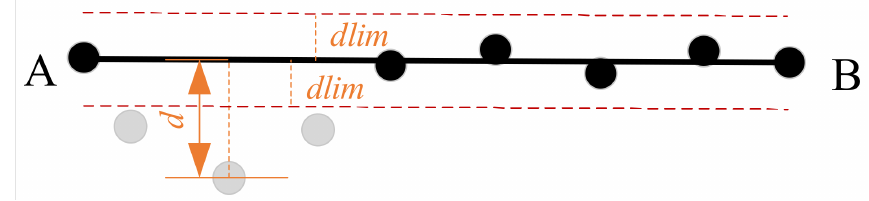
Figure 5. Schematic diagram of processing method for abnormal points at